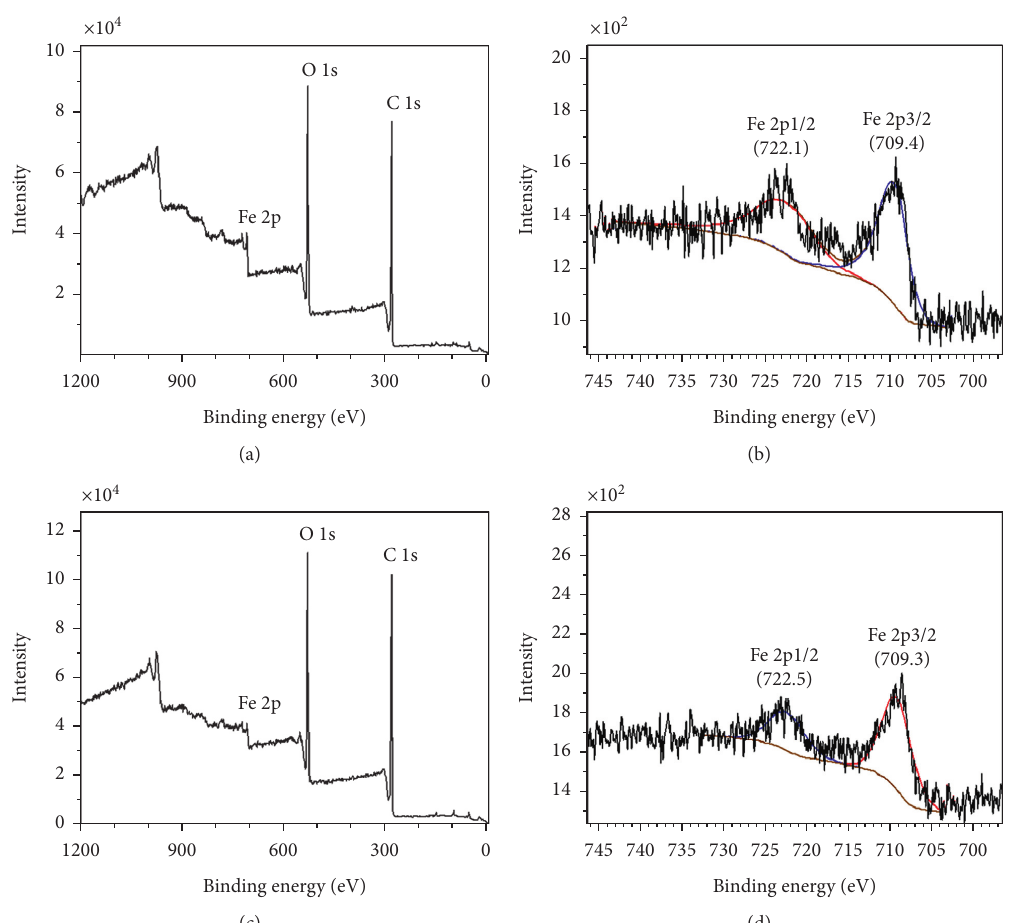
Figure 10: XPS spectra of iron (III) benzene dicarboxylate samples synthesized at 150 ° C and 24h with different Fe (III)/BDC molar